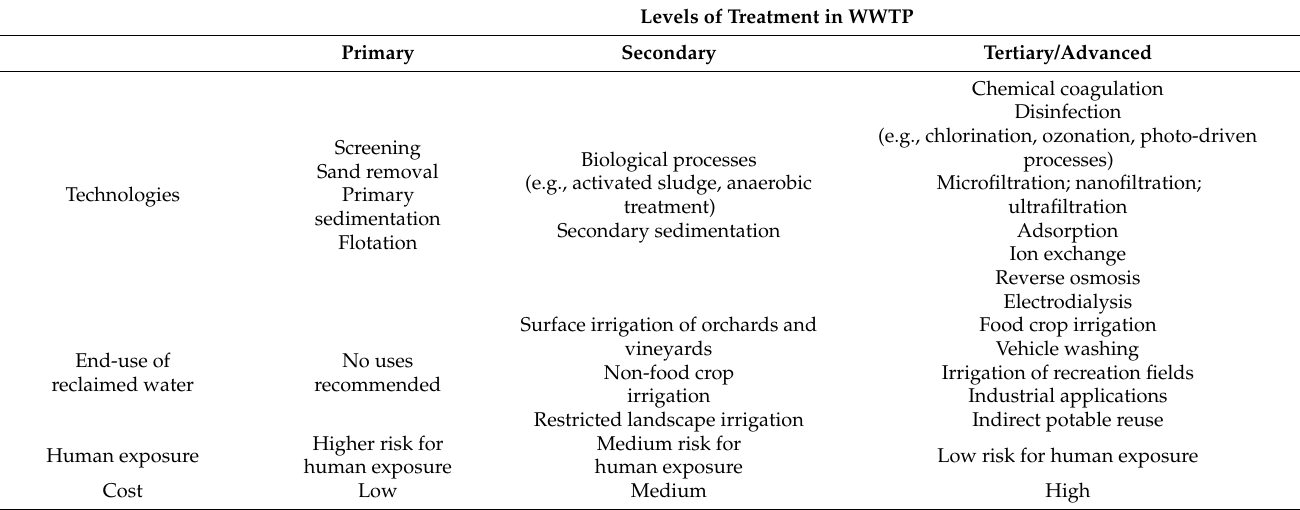
Table 6. Treatment technologies to produce reclaimed water, according to each level of treatment, and examples of applications